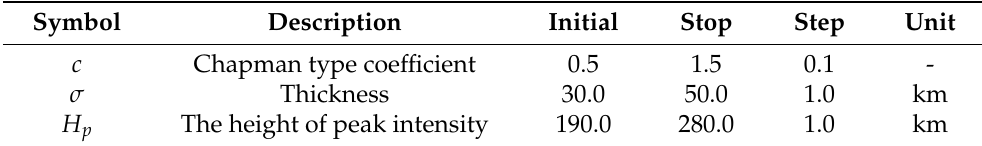
Table 1. The setup for self-generated profiles as